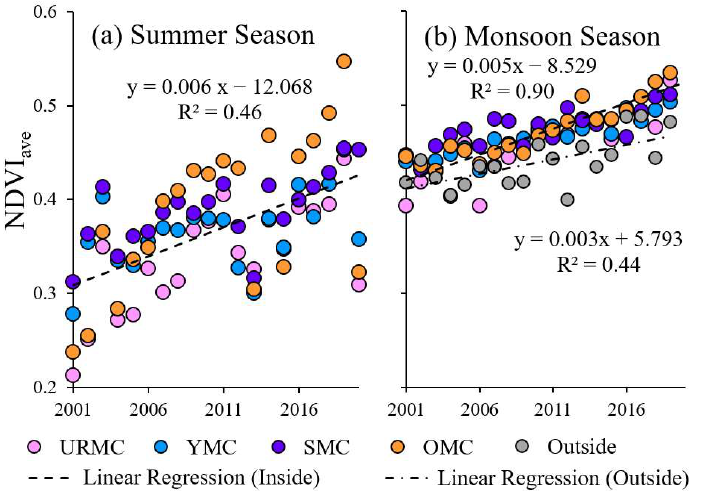
Figure 10. Seasonal average NDVI for ( a ) summer and ( b ) monsoon by year.